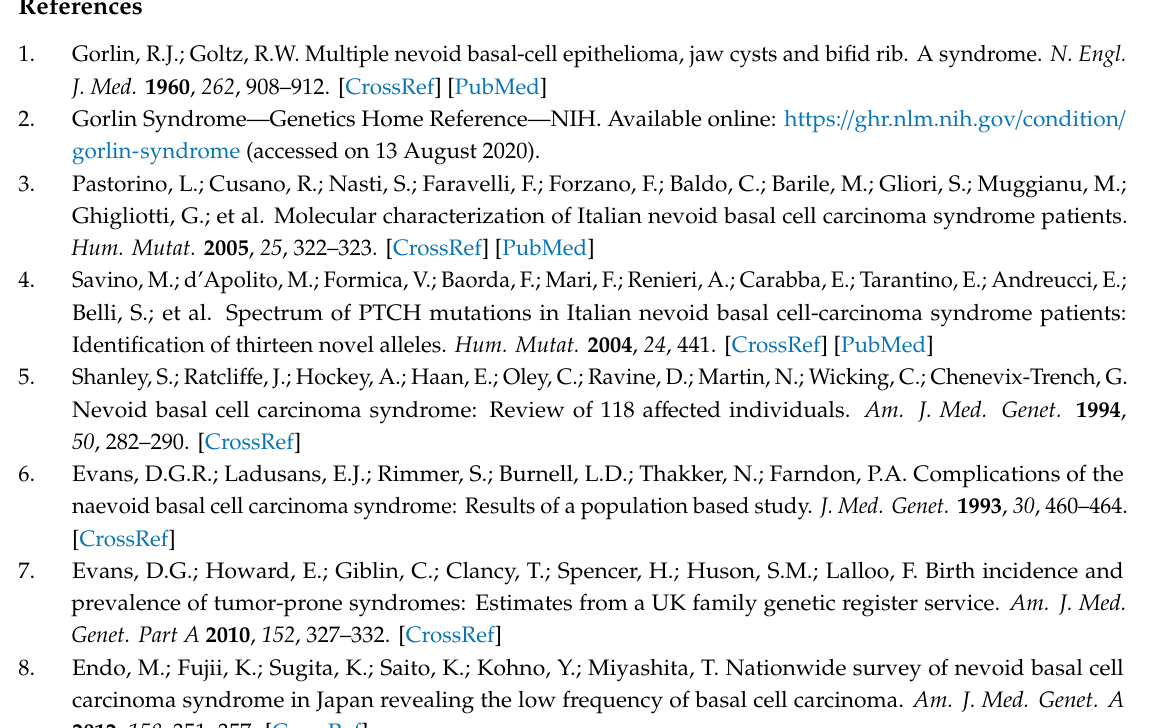
Table S1: The list of the mutations in patients with